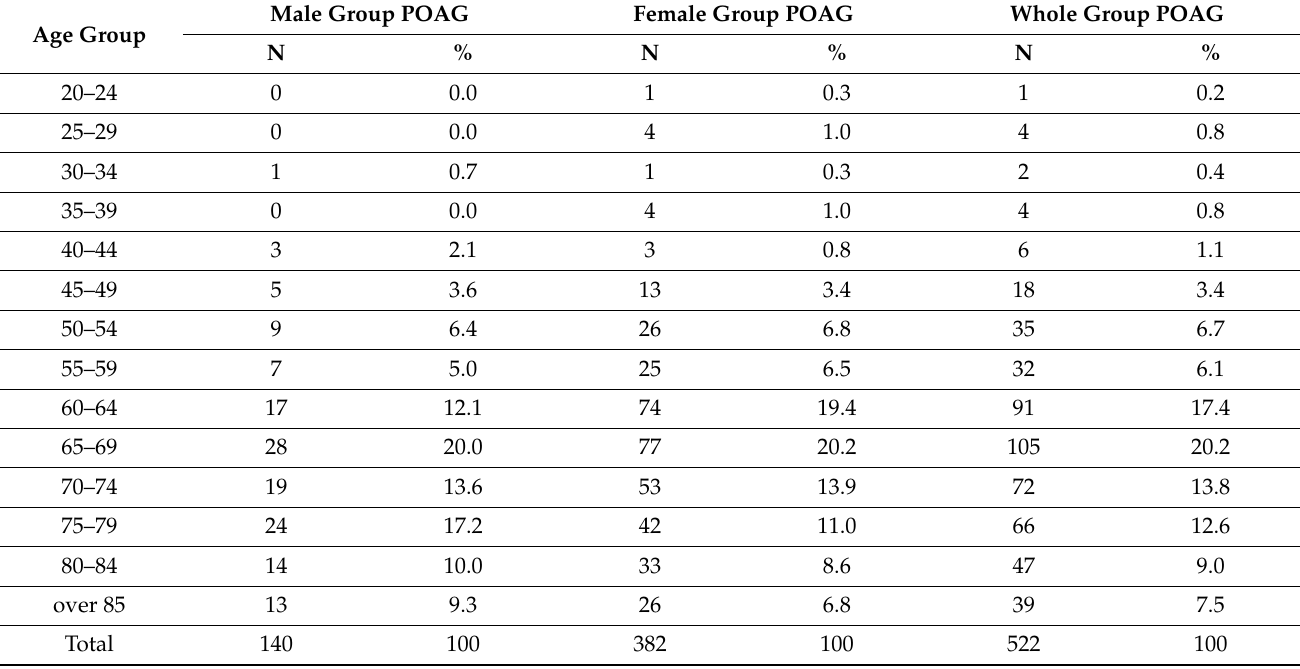
Table 2. Distribution of patients with POAG by gender and age group in